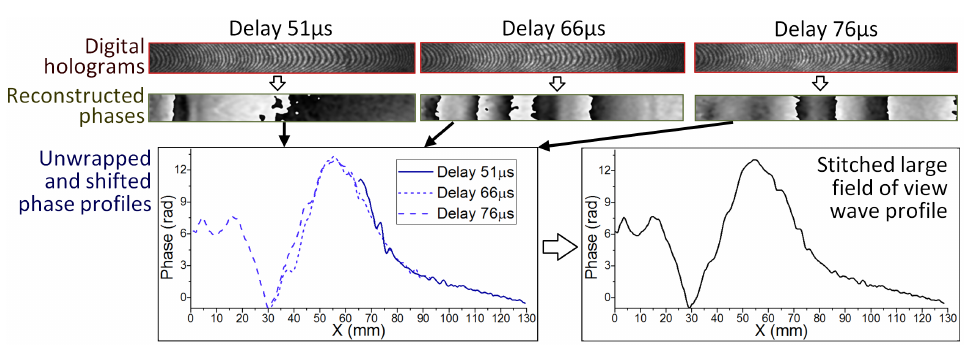
Figure 2. Reconstruction of elastic wave profile by stitching three digital holograms obtained at different delays between the moments of shock wave generation and hologram recording. Waves travel from left to